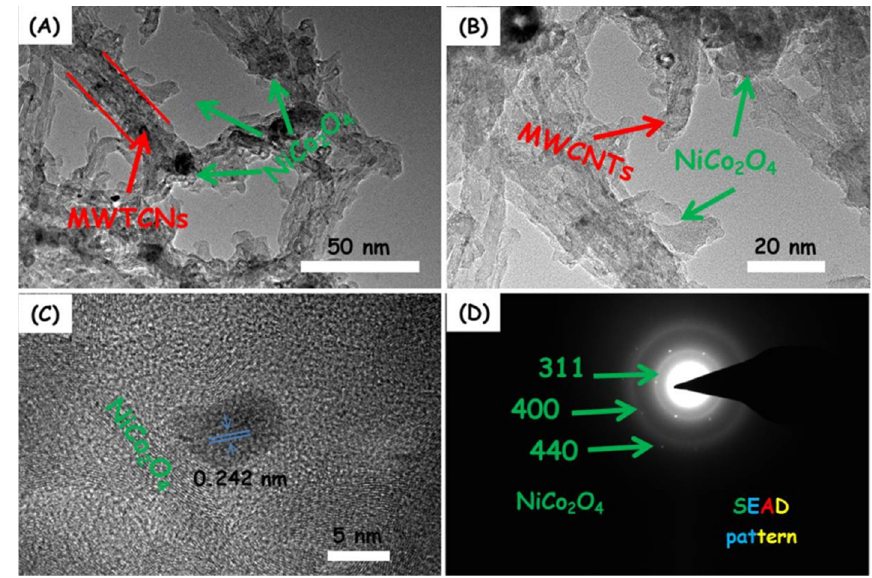
Figure 2. ( A , B ) TEM, ( C ) HRTEM, and ( D ) SAED pattern of NiCo 2 O 4